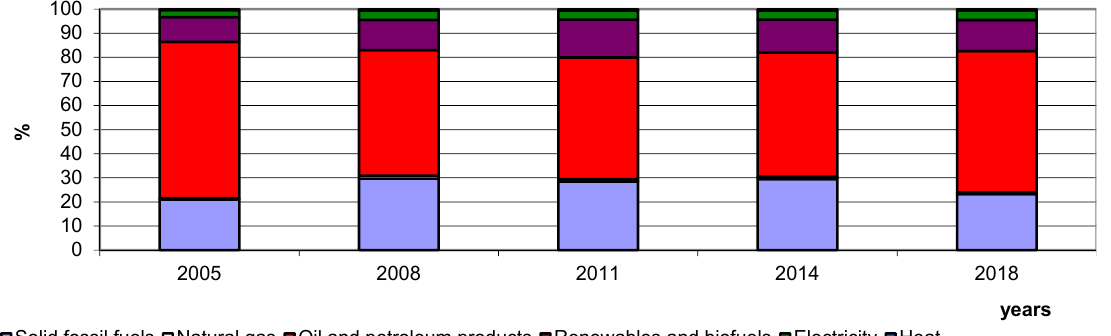
Figure 8. Structure of energy used in agriculture in Poland in 2005–2018.